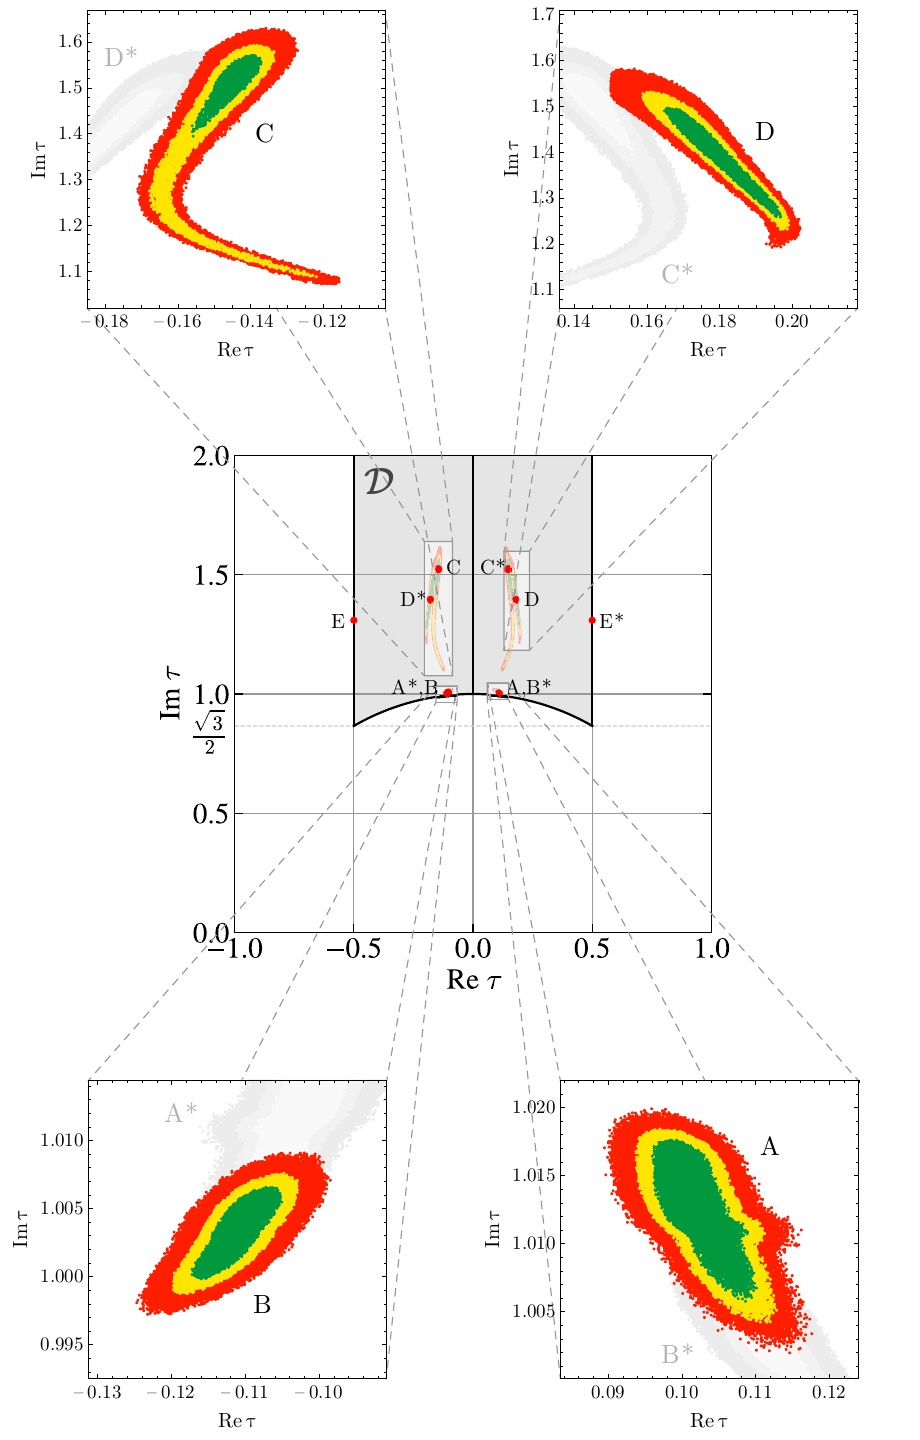
Figure 1. Red dots signal (cid:28) values inside the fundamental domain D of the modular group corre- sponding to the (cid:12)ve pairs of (cid:1) (cid:31) 2 minima in the case of ( k (cid:3) ; k g ) = (0 ; 2). Here and in the following plots, the green, yellow and red regions correspond to 2 (cid:27) , 3 (cid:27) and 5 (cid:27) con(cid:12)dence levels, respectively.